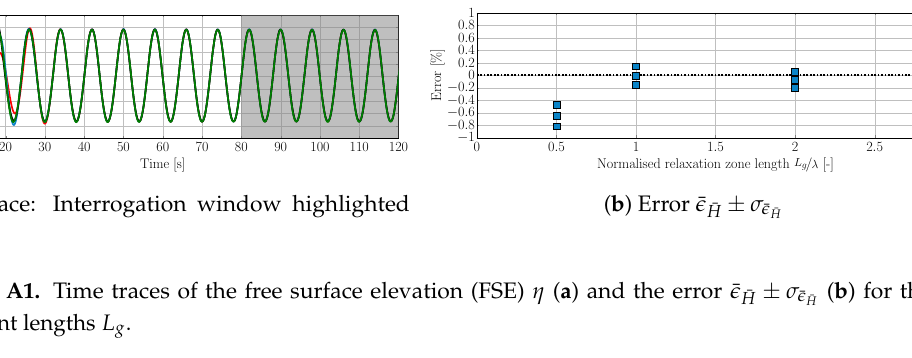
Figure A1. Time traces of the free surface elevation (FSE) η ( a ) and the error ¯ (cid:101) ¯ different lengths L g